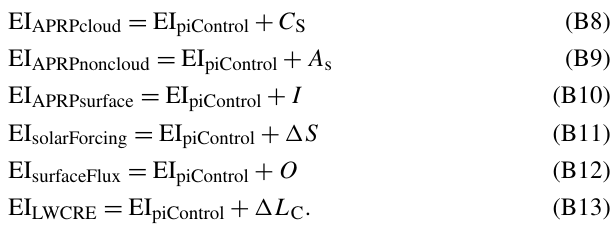
Table B1. Values of fit coefficients for clear-sky OLR as a function of temperature for use in moist EBM analysis.